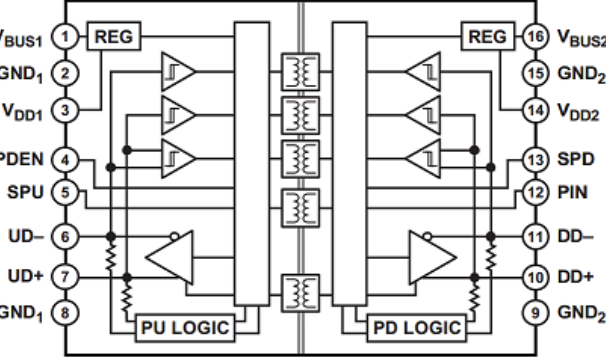
Fig. 10. Functional block diagram of galvanic isolation